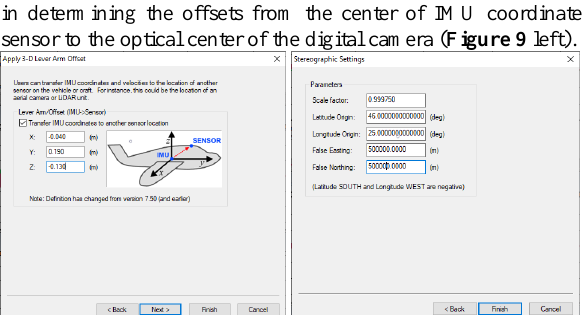
Figure 9 . Exporting the images orientations and centre of projections and the essential